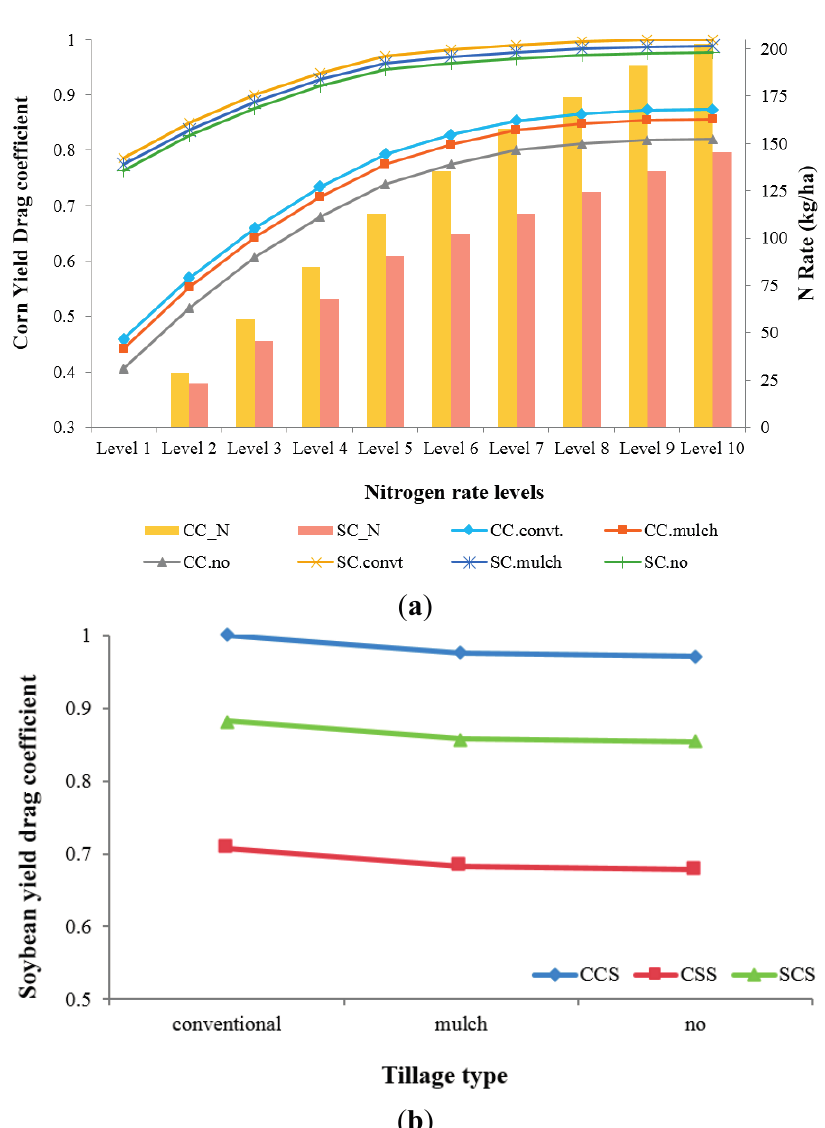
Figure A1. Corn yield drag coefficients ( a ) for different rotation, tillage, and N fertilizer rate levels, and soybean yield drag coefficients; ( b ) for different rotation types: Corn is denoted as “C” and soybean as “S”, the last letter in a rotation pattern means the current crop (e.g., CCS means corn-corn-soybean, and soybean is in the current